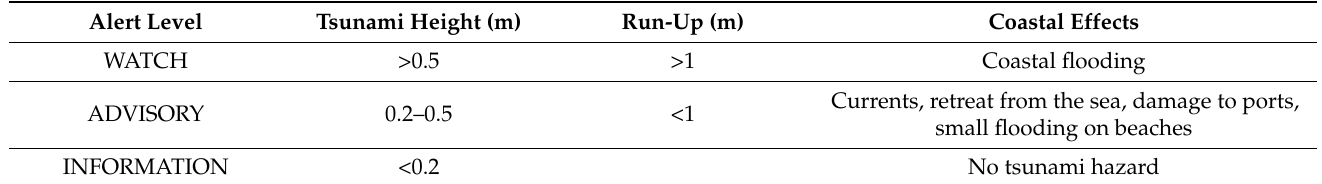
Table 1. Tsunami alert levels considered on the NEAMTWS and used in the Spanish TWS.